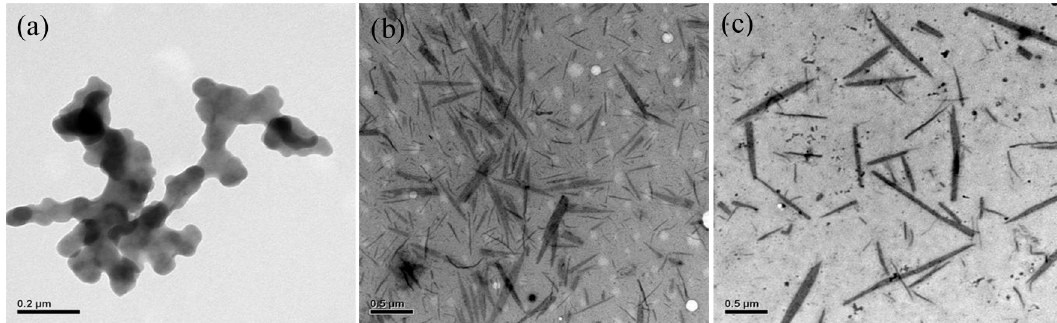
Figure 9. TEM images of POF 10 – b– PDPAEMA 90 aggregates in water at different pH levels: ( a ) 2, ( b ) 7, ( c ) 11.